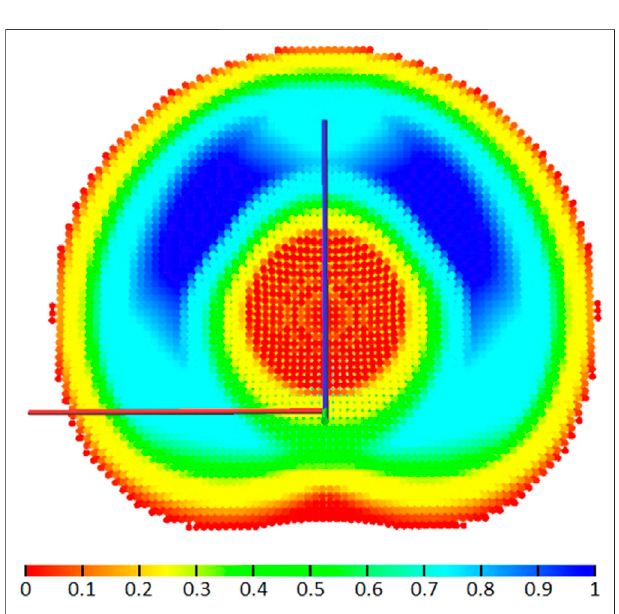
FIGURE4| Cross-sectionofthefailuremap W f